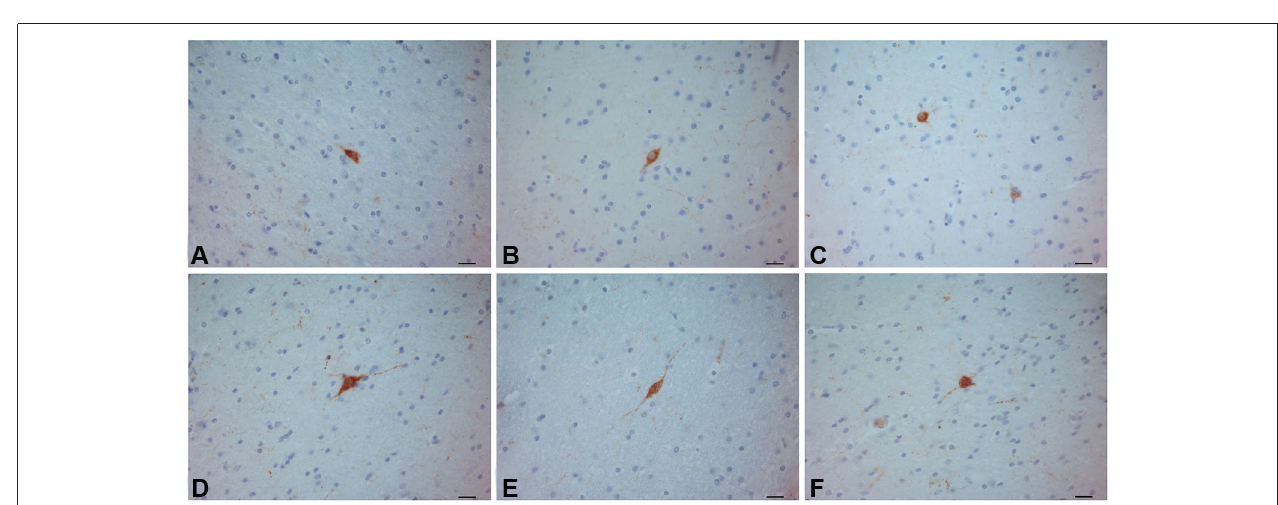
FIGURE 7 | Low-magnification images of the CBPs in the human claustrum. (A) CR-immunoreactive neurons; a and b are enlargements of the corresponding red rectangles in A ; (B) Reference image stained with